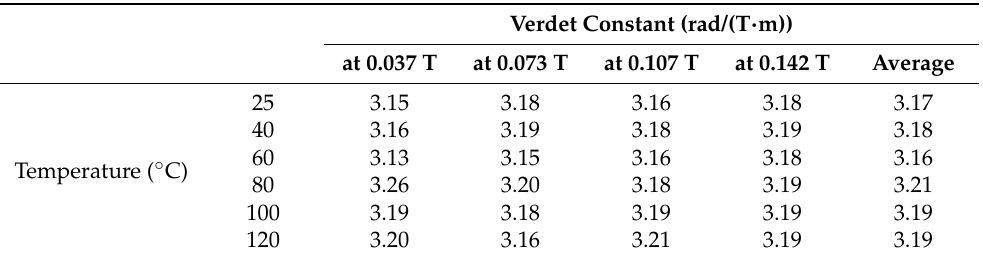
Table 1. Verdet constants of the Gd 2 O 3 NPs-doped fiber upon applying the magnetic fields at various constant temperatures.